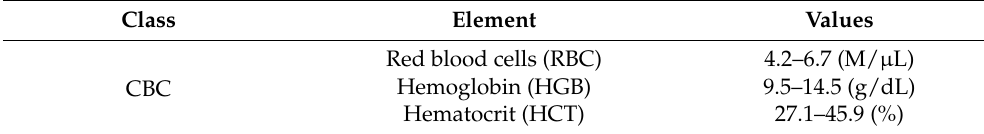
Table 3. Blood markers of the